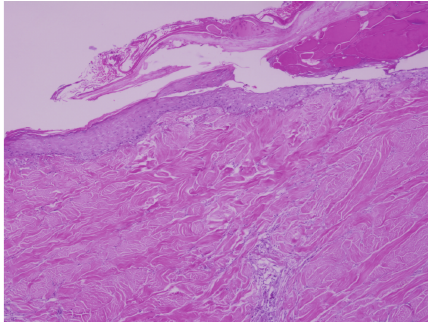
Figure 2: Hematoxylin and eosin. 5X. Atrophic epidermis with necrosis and central ulceration. Dermal sclerosis, loss of dermal appendages.